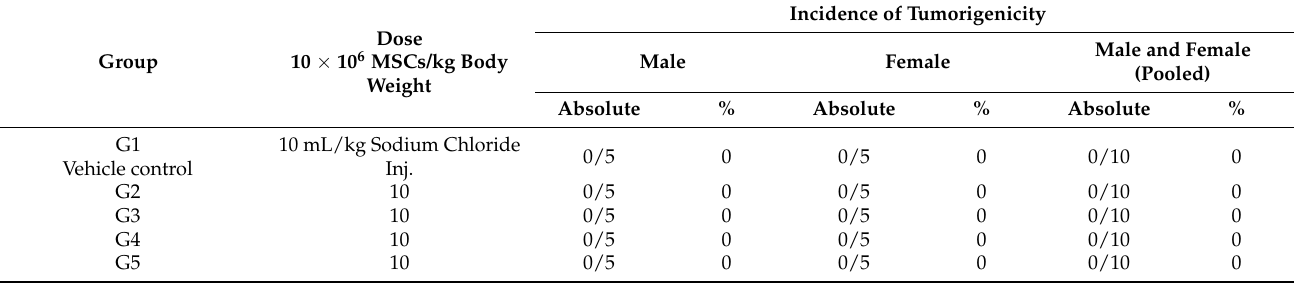
Absolute tumorigenicity is presented as number of animals died/numbers